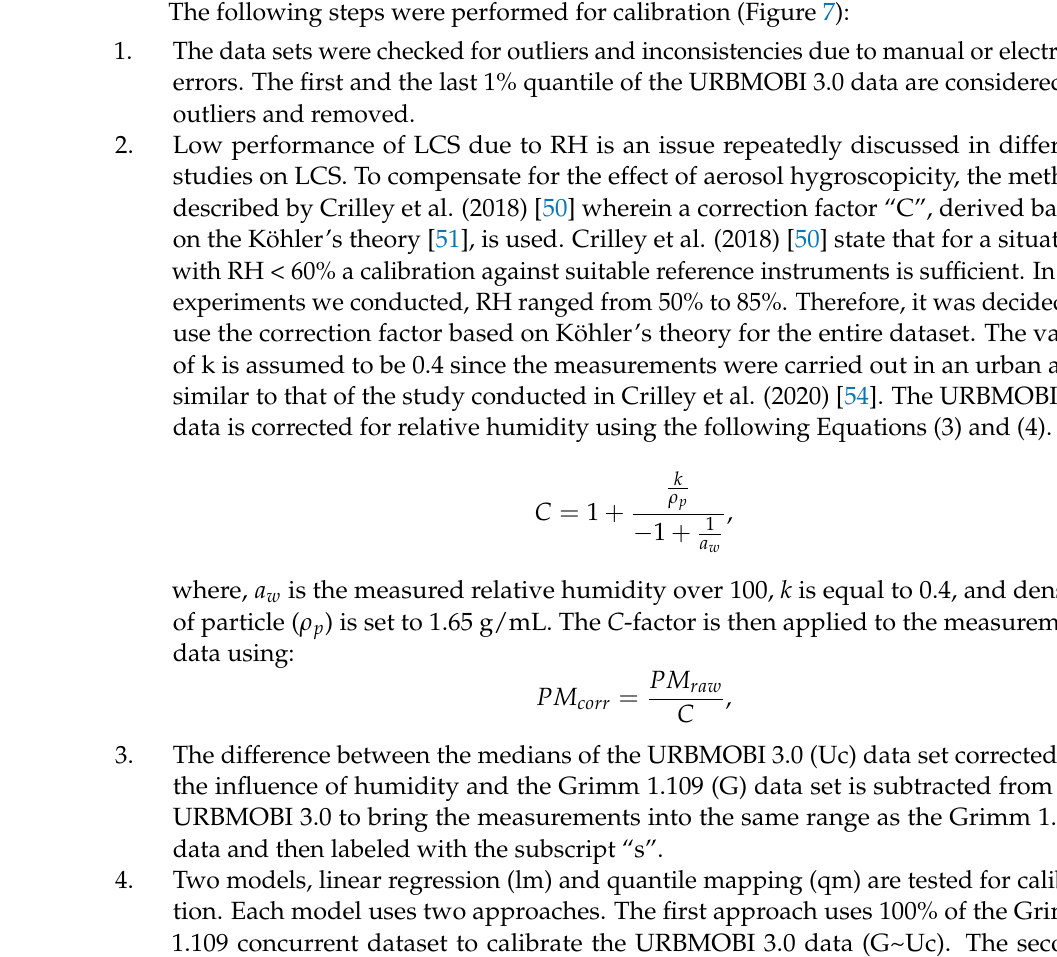
Figure 6. Measurement route at Berlin-Hermsdorf across different local climate zones and land use classes.